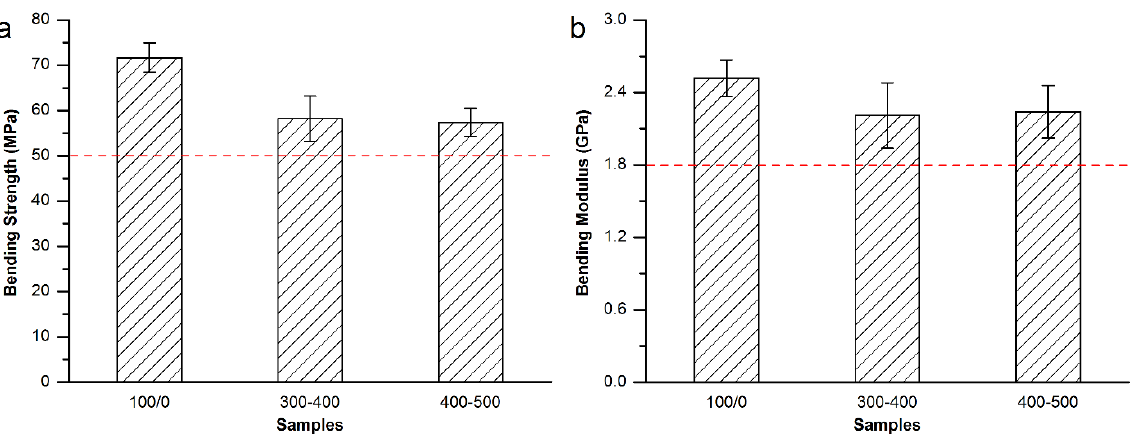
Figure 8. ( a ) Bending strength and ( b ) bending modulus of the MC modified Spineplex™ bone cement.